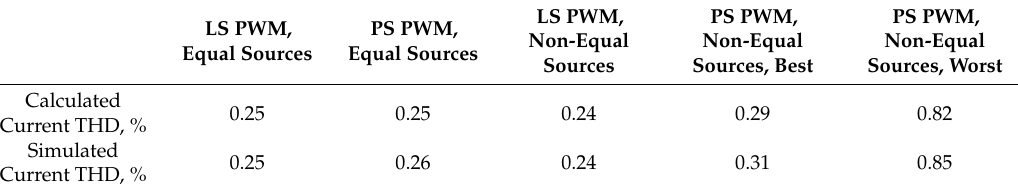
Table 4. Current THD for a Single-Phase Six H-Bridge CHB.